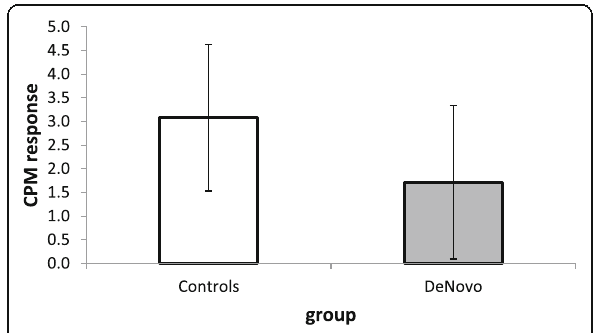
Fig. 2 Conditioned pain modulation magnitudes are shown for healthy controls and de novo PD patients. Means and standard error of means are presented. There were no group differences between de novo patients (gray bar) and controls (white